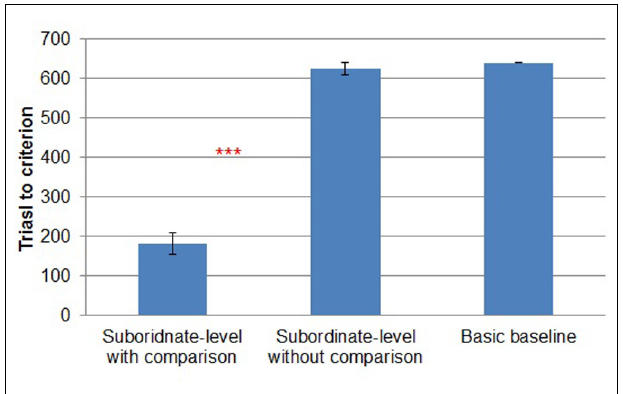
FIGURE 2 |Trials to criterion by study condition in Experiment 1. Error bars represent SEs. *** p <